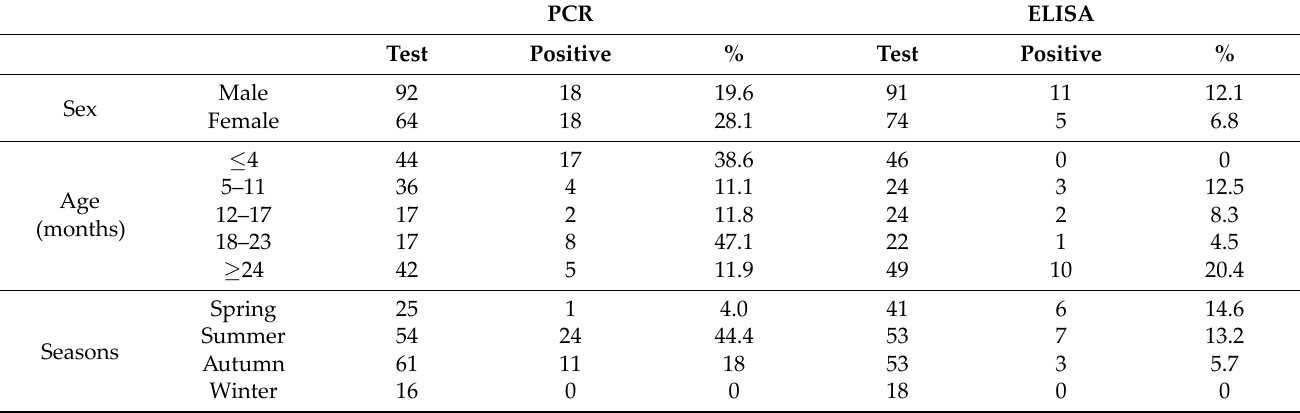
Table 1. Positive cases were observed during PCR and ELISA, classified in various categories, in raccoons investigated in this study from June 2020 to April 2022 in the Tama area, Tokyo,